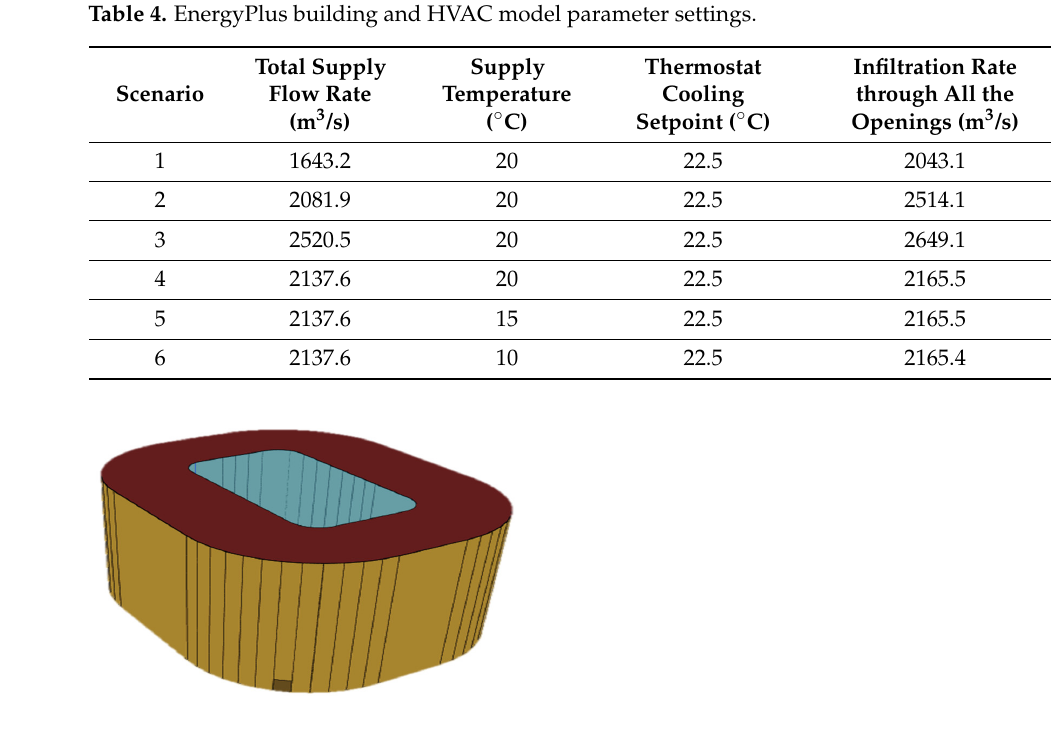
Figure 6. A simplified BES model of the stadium.